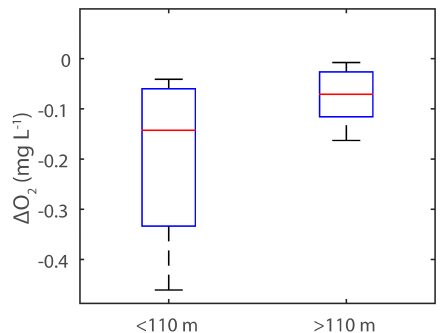
Figure 5. Net effect of the turbidity layer on O 2 concentrations calculated for intrusion above ( n = 8) and below ( n = 13) the deep winter maximum